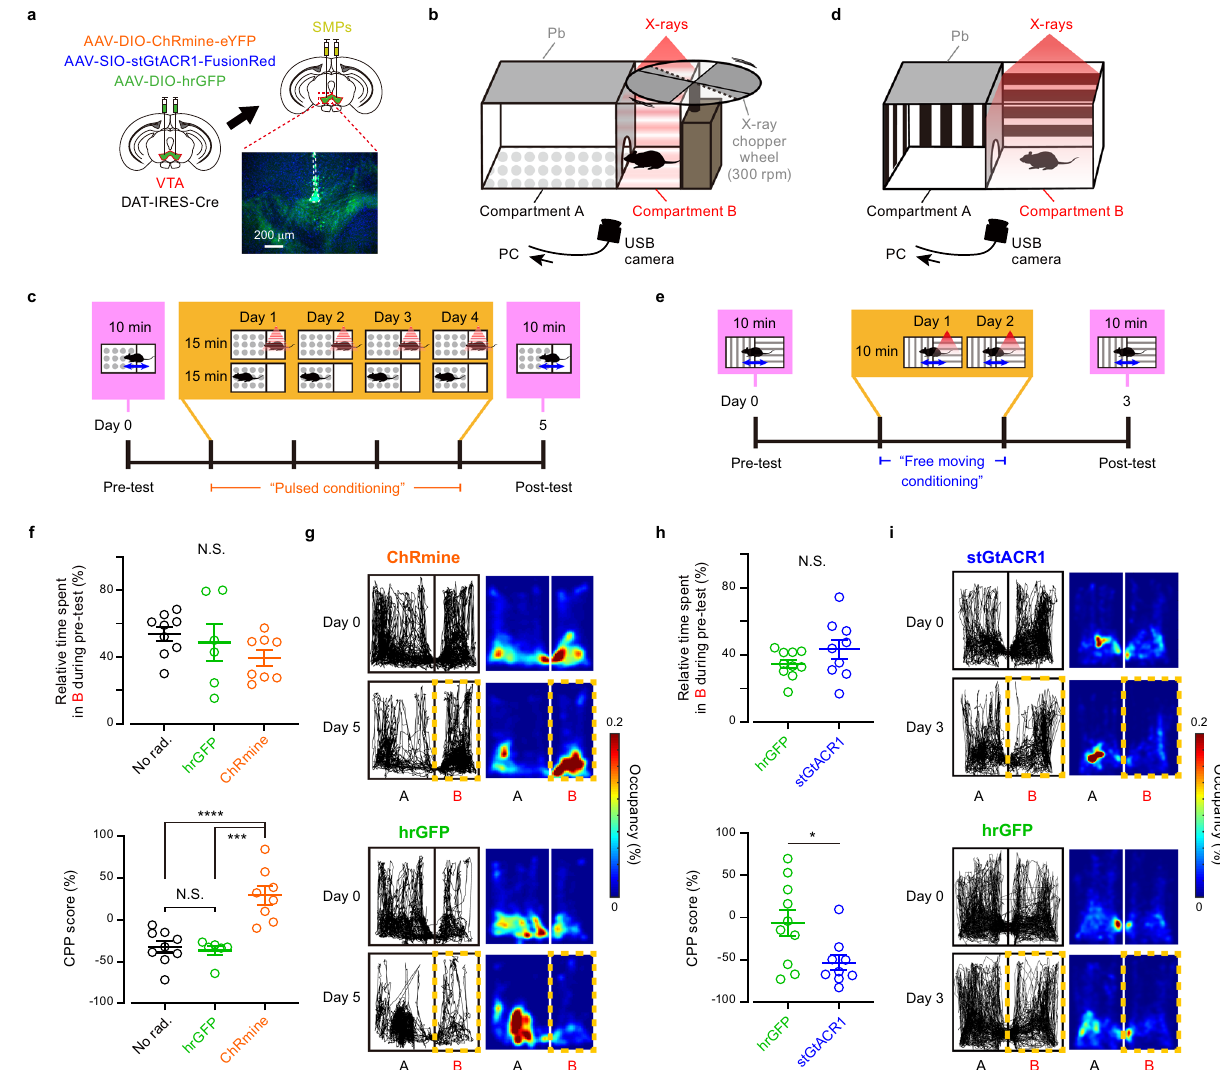
Fig. 5 Scintillator-mediated wireless optogenetics drove conditioned place preference and aversion in freely behaving mice. a Schematic of the experiment. Inset: an epi- fl uorescence image showing SMPs (dashed outline) injected at dorsal VTA. Green: ChRmine-eYFP, Blue: DAPI. Similar results were obtained in 21 mice. b CPP test chamber for “ Pulsed conditioning ” (PC). The X-ray shieldings and the X-ray wheel chopper are made of lead (Pb). c Time course of CPP test with PC. The gate between two compartments is open for pre-tests and post-tests but closed during PC. d CPP test chamber for “ Free moving conditioning ” (FC). e Time course of CPP test with FC. The gate between the two compartments is open throughout the test. f Quanti fi cation of CPP with PC ( n = 9 mice for no radiation control [No rad.] group, 6 mice for hGFP group, 8 mice for ChRmine group). Pre-test (top), F (2,20) = 1.48, p = 0.252; post-test (bottom), F (2,20) = 19.0, p < 0.0001; one-way ANOVA. Post-test (bottom): No rad. vs. hrGFP, p > 0.9999; No rad. vs. ChRmine, **** p < 0.0001; hrGFP vs. ChRmine, *** p = 0.0001; Bonferroni ’ s multiple comparison test, two-sided. g Representative tracking data (left) and the corresponding heat maps (right) for mice before (Day 0) and after (Day 5) PC, as extracted from oblique-view movies. h Quanti fi cation of CPP with FC ( n = 10 mice for hGFP group, 9 mice for stGtACR1 group). Pre-test (top), p = 0.243; post-test (bottom), * p = 0.0435; Mann – Whitney U test, two-sided. i Same as g , but for mice before (Day 0) and after (Day 3) FC. N.S., not signi fi cant. Open circles indicate individual data. Values are mean ±